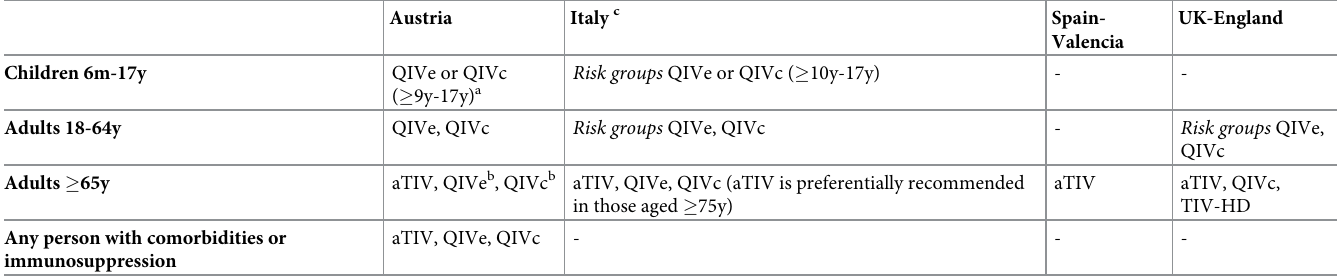
Table 1. Risk groups covered by the survey and influenza vaccine types recommended for use in these risk groups, by country,